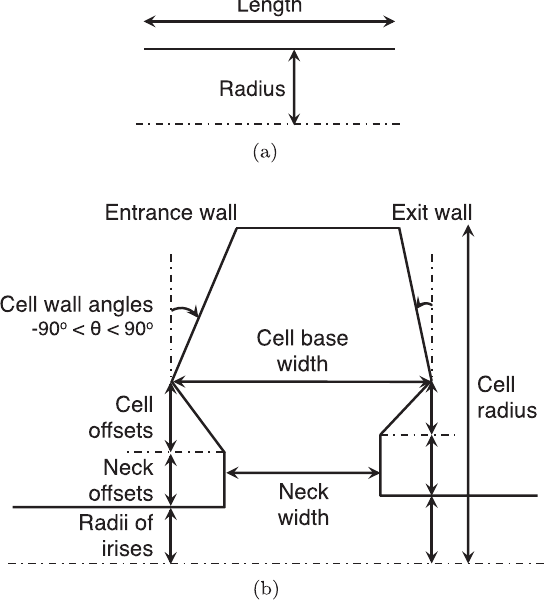
FIG. 22. Beam tube and cell parameters in general cavity description [25]: (a) beam tube or iris; (b) cell. The beam enters each element on the left. Fig. 23. In the geometry description, each cell is described